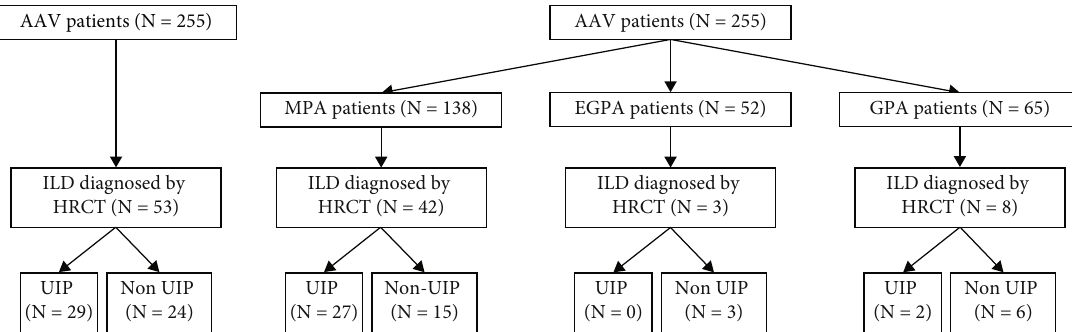
Figure 1: Algorithm for subject selection. AAV: ANCA-associated vasculitis; ANCA: antineutrophil cytoplasmic antibody; MPA: microscopic polyangiitis; EGPA: eosinophilic granulomatosis with polyangiitis; GPA: granulomatosis with polyangiitis; ILD: interstitial lung disease; HRCT: high-resolution computed tomography; UIP: usual interstitial pneumonia. Table 2: Comparison of ILD patterns among three AAV subtypes ( N = 255 ).